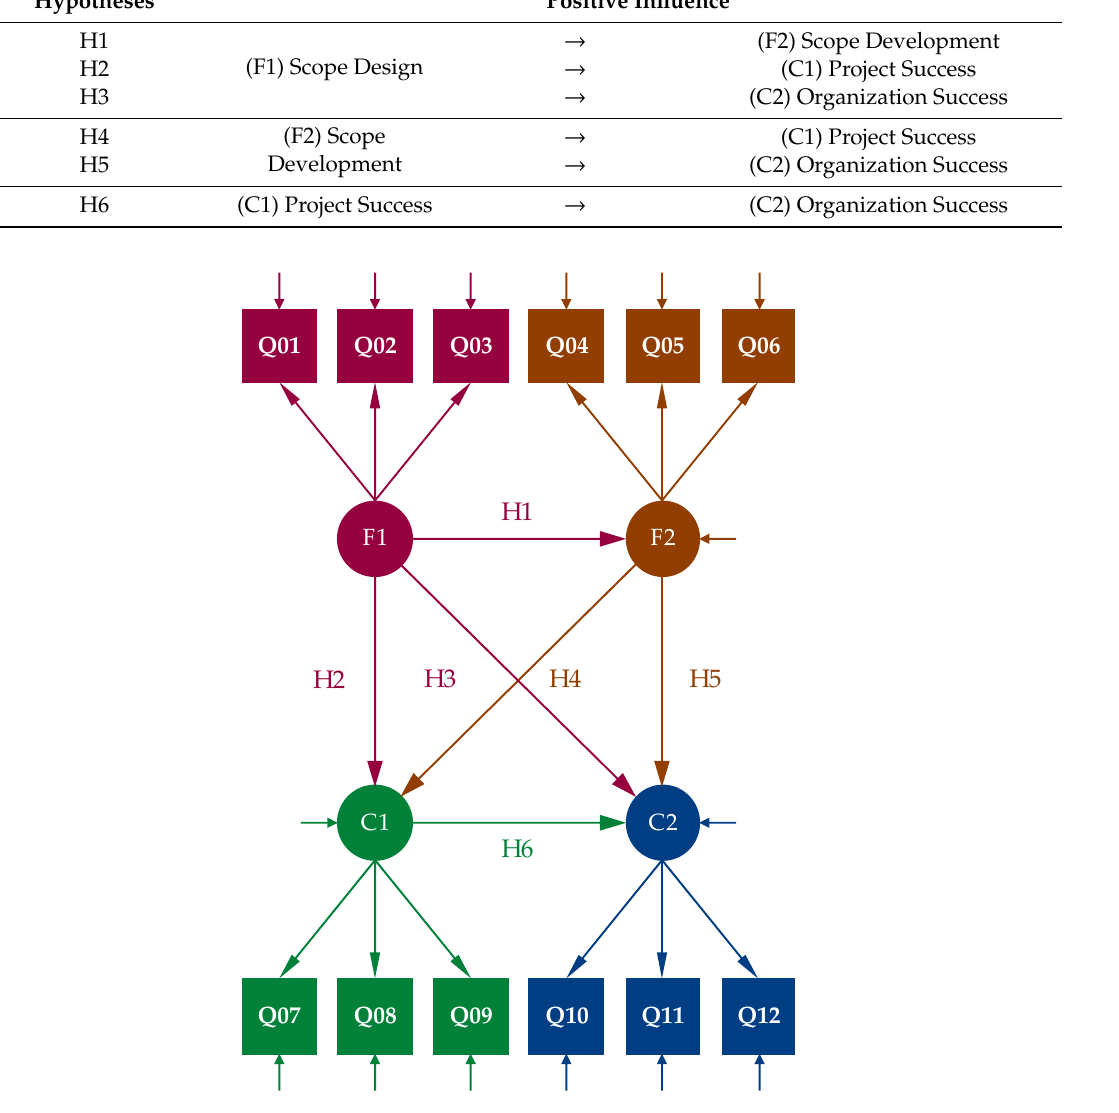
Table 13. Principal components analysis of the factors related to work design (F1) and work development (F2).